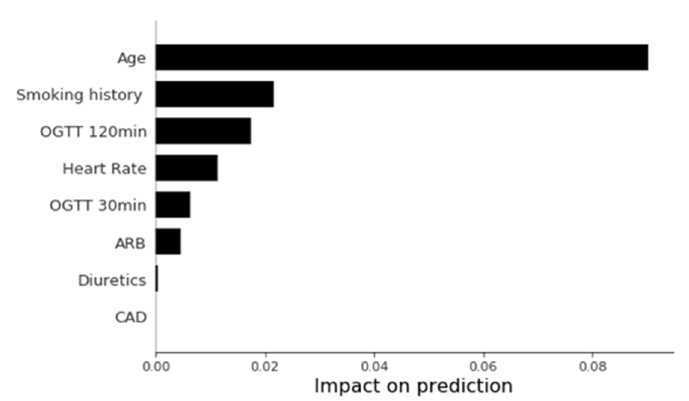
Figure 2. Impact of selected features on model prediction. The impact on prediction was based on the SHAP value, which was calculated from the best performing model. (ARB = angiotensin II receptor blocker, CAD = coronary artery disease, OGTT = oral glucose tolerance test, SHAP = Shapley Additive Explanation values). Table 2. Features selected by the LASSO-derived Cox proportional hazards model.